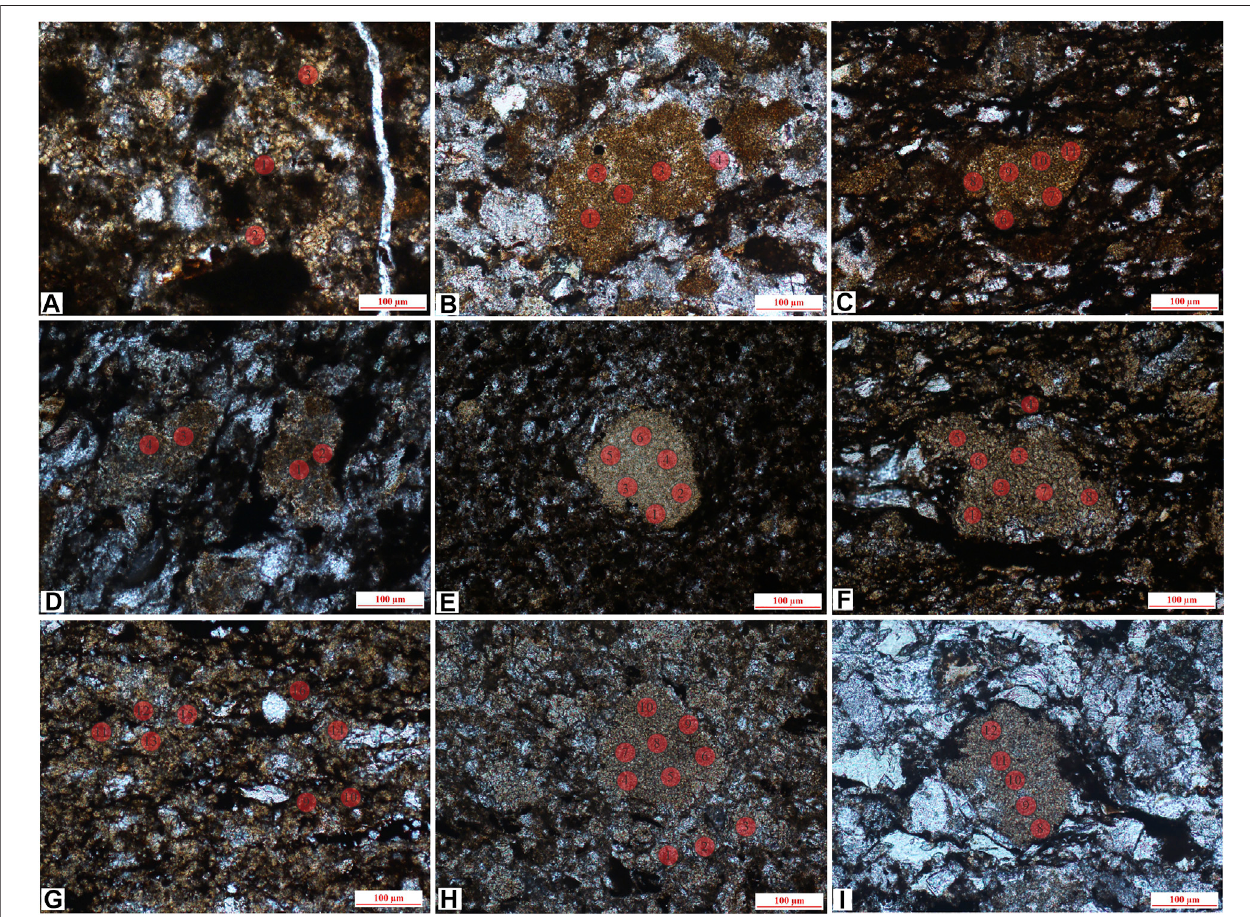
FIGURE 5 | In situ sites of gelatinous siderite and microlite siderite, (A) J-1, gelatinous siderite and partly recrystallized into powder crystal siderite (lane-polarized light); (B,C) J-6, mass aggregate, distributed among debris particles (lane-polarized light); (D) J-12, siderite is evenly distributed (lane-polarized light); (E) J-16, mass aggregatesideriteandevenlydistributedgelatinoussiderite(lane-polarizedlight); (F,G) J-5,uniformdistribution,microlitesiderite(lane-polarizedlight); (H) J-11,microlite siderite is evenly distributed (lane-polarized light); (I) J-10 (1), mass microlite siderite is distributed between clastic particles (lane-polarized light).